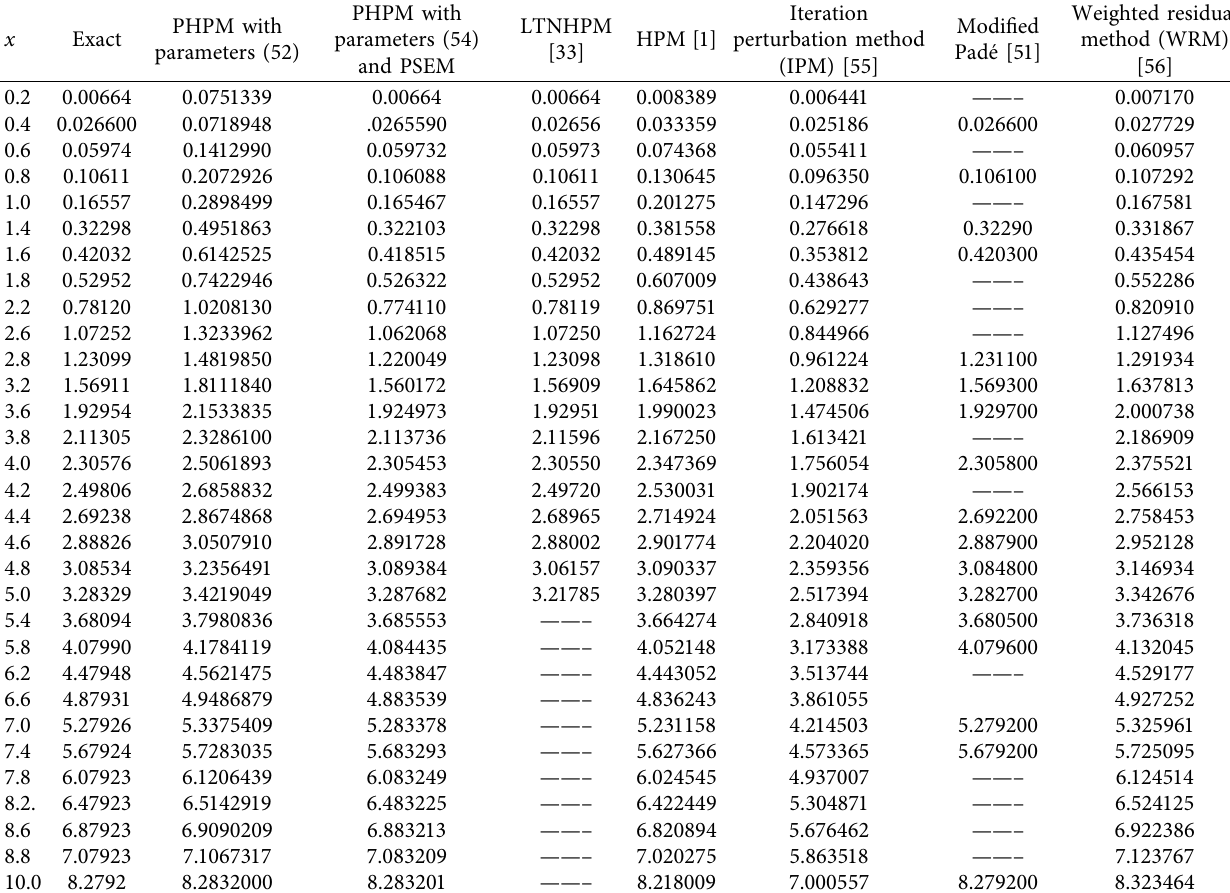
Table 1: Comparison of the results obtained for this work with other